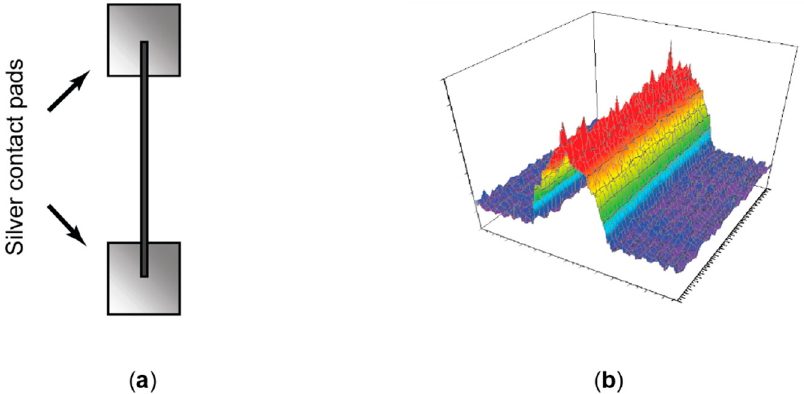
Figure 2. The silver NP array in the form of line: ( a ) a model of the line printed between two silver contact pads and ( b ) a 3D image of the printed line taken by an optical profiler.